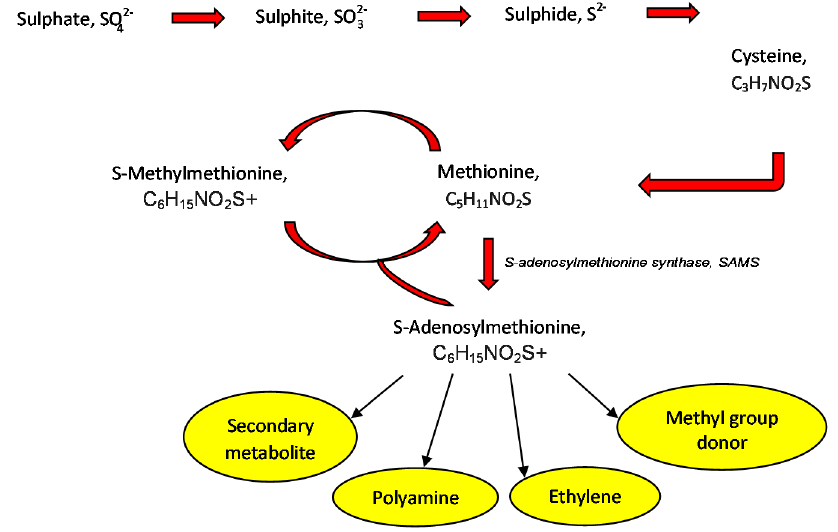
Figure 3. Outline of regulatory and protective compounds anabolism stimulated by S-Methylmethonine.